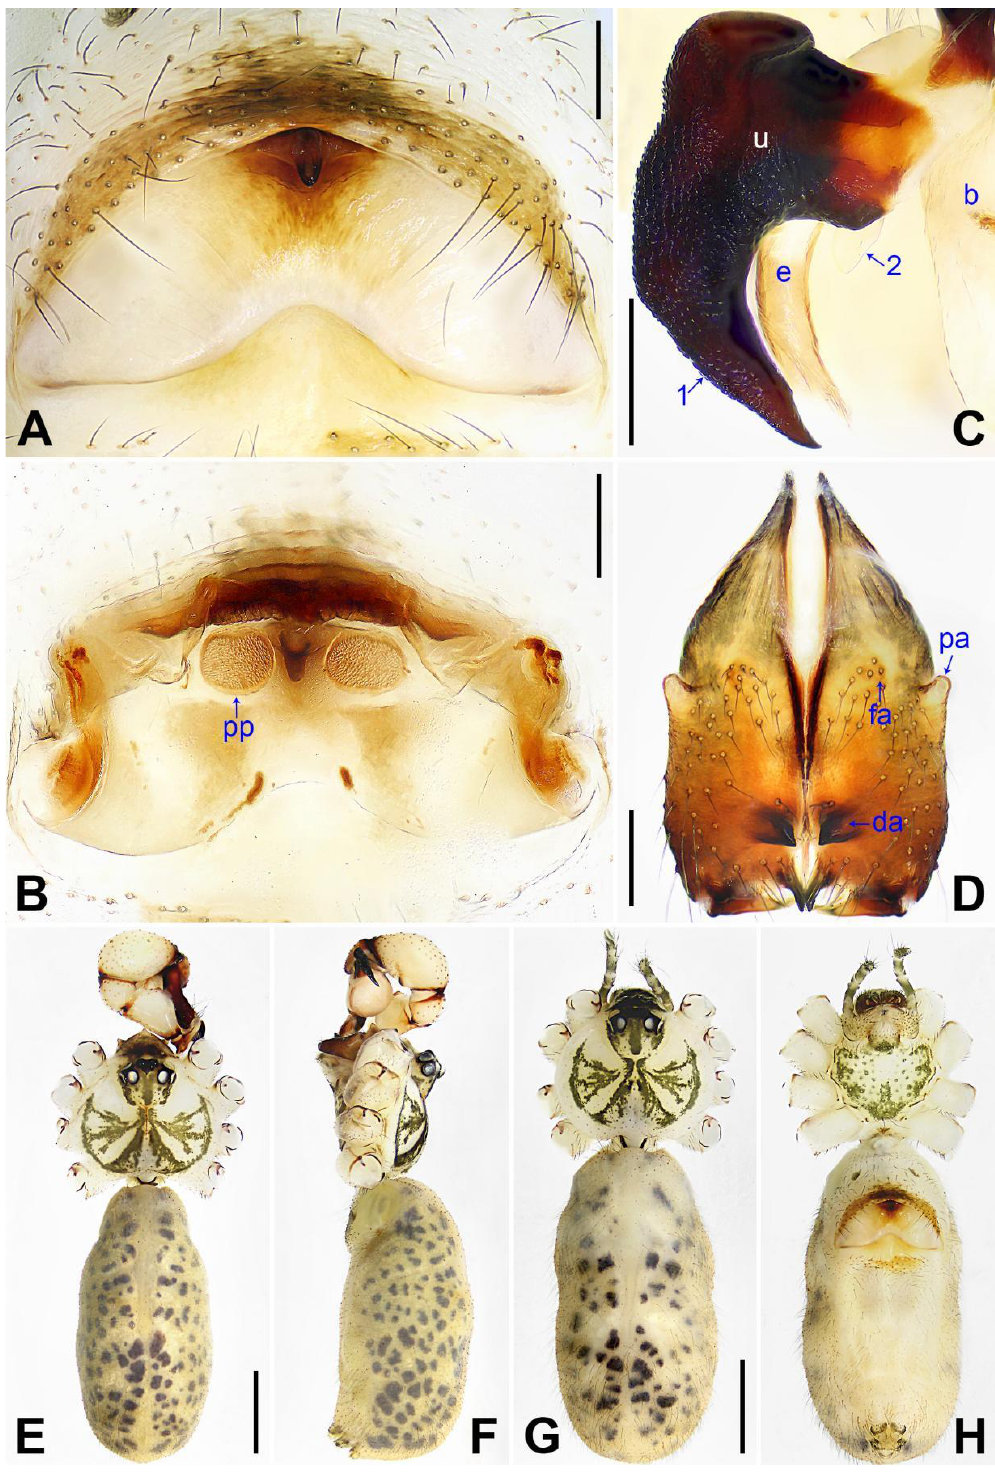
Figure 10. Pholcus luliang sp. nov., holotype male ( C – F ) and paratype female ( A , B , G , H ): ( A ) epigyne, ventral view; ( B ) vulva, dorsal view; ( C ) bulbal apophyses, prolateral view (arrow 1 points at distal apophysis, arrow 2 points at “pseudo-appendix”); ( D ) chelicerae, frontal view; ( E , G ) habitus, dorsal view; ( F ) habitus, lateral view; ( H ) habitus, ventral view. da = distal apophysis, e = embolus, fa = frontal apophysis, pa = proximo–lateral apophysis, pp = pore plate, u = uncus. Scale bars: ( A – D ) = 0.20 mm; ( E – H ) = 1.00 mm.